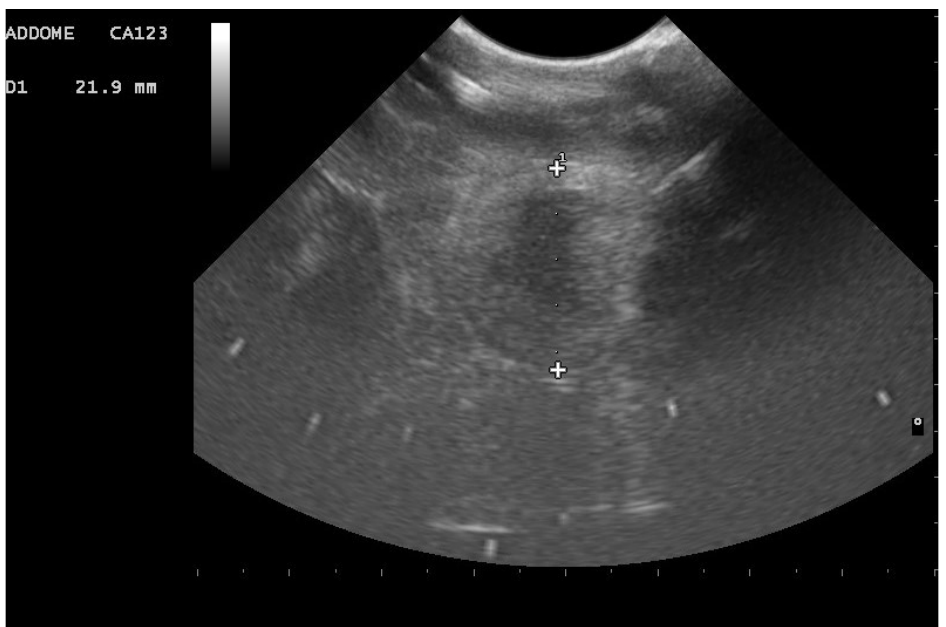
Figure 3. Follicle in a female boa during coupling. The follicle shows a central anechoic area surrounded by a more echogenic peripheral area. Recognized in 100% of the females involved in the study. In 90% of females (27/30), follicles with an onion-ring-like appearance were high- lighted (Figure 4).